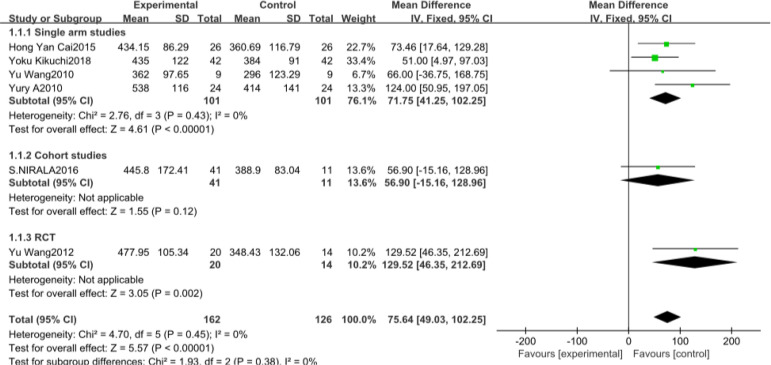
Forest map for the six-min walking distance test of the cardiac shock wave therapy group and the control group. CI=confidence interval; IV=inverse variance methods; RCT=randomised controlled trial; SD=standard deviation